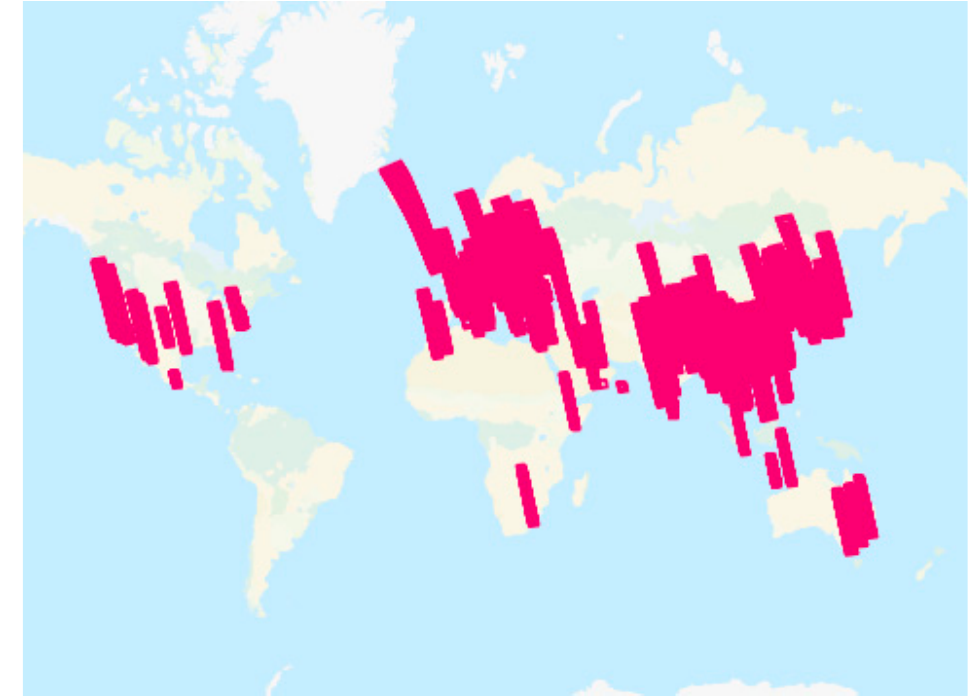
Figure 5. LJ1-01 data coverage since 2018. Source: [12].